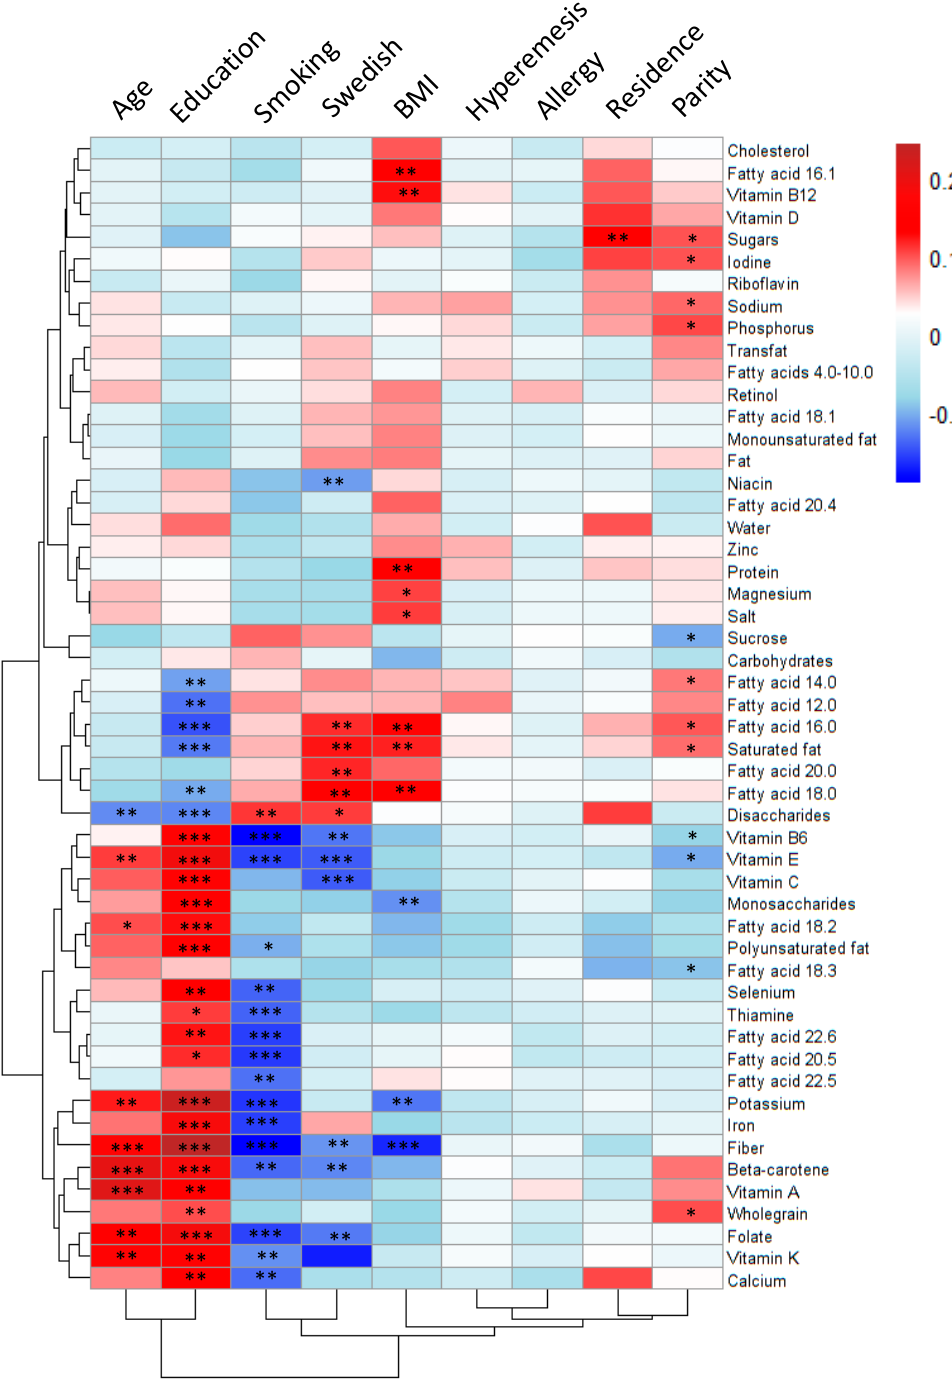
Figure 6. Heat map of correlations between micronutrients and maternal characteristics ( N = 567). The magnitude of each correlation is designated by a color, whereby the dark-red color indicates a strong positive correlation, and dark-blue color represents a strong negative correlation. Univariate statistics were used to find significant associations. For dichotomous variables, i.e., parity, smoking, hyperemesis, and allergy, the Mann–Whitney U -test was used. For categorical variables, such as education and residential address, the Kruskal–Wallis test was used. For continuous variables, such as age and BMI, Spearman’s correlation test was used. Levels of statistical significance are denoted as: * p < 0.05, ** p < 0.01, *** p <